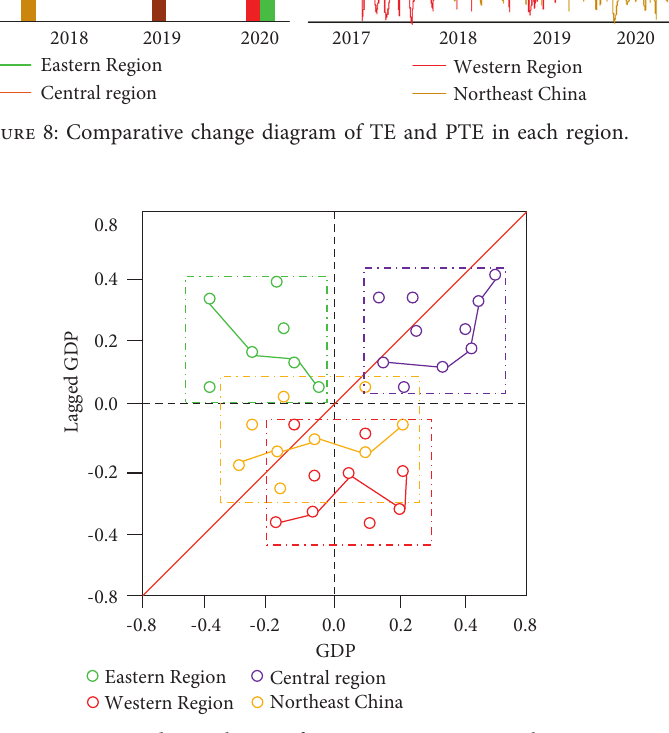
Figure 9: Scattered spatial map of GDP aggregation in each